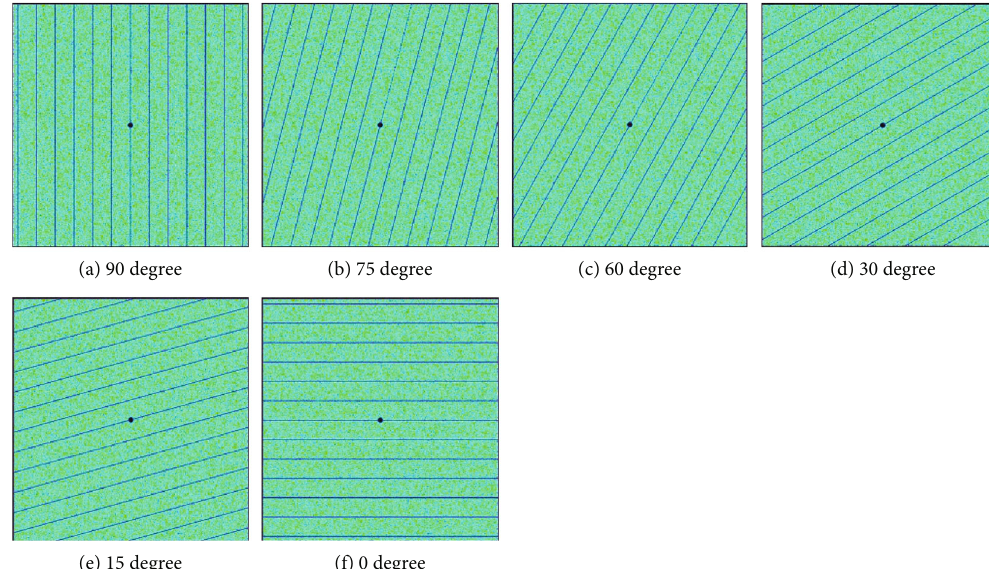
Figure 12: Model with di ff erent dip angles of bedding plane [55].